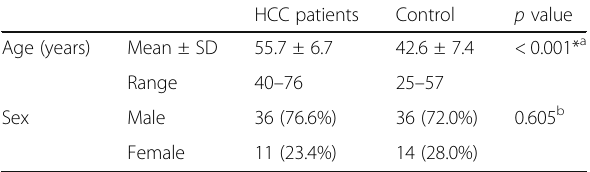
Table 1 General characteristics of HCC and HCV cases